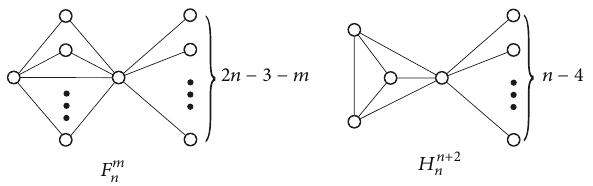
Figure 1: Graphs 𝐹 𝑚 𝑛 and 𝐻 𝑛+2 𝑛 in Lemma